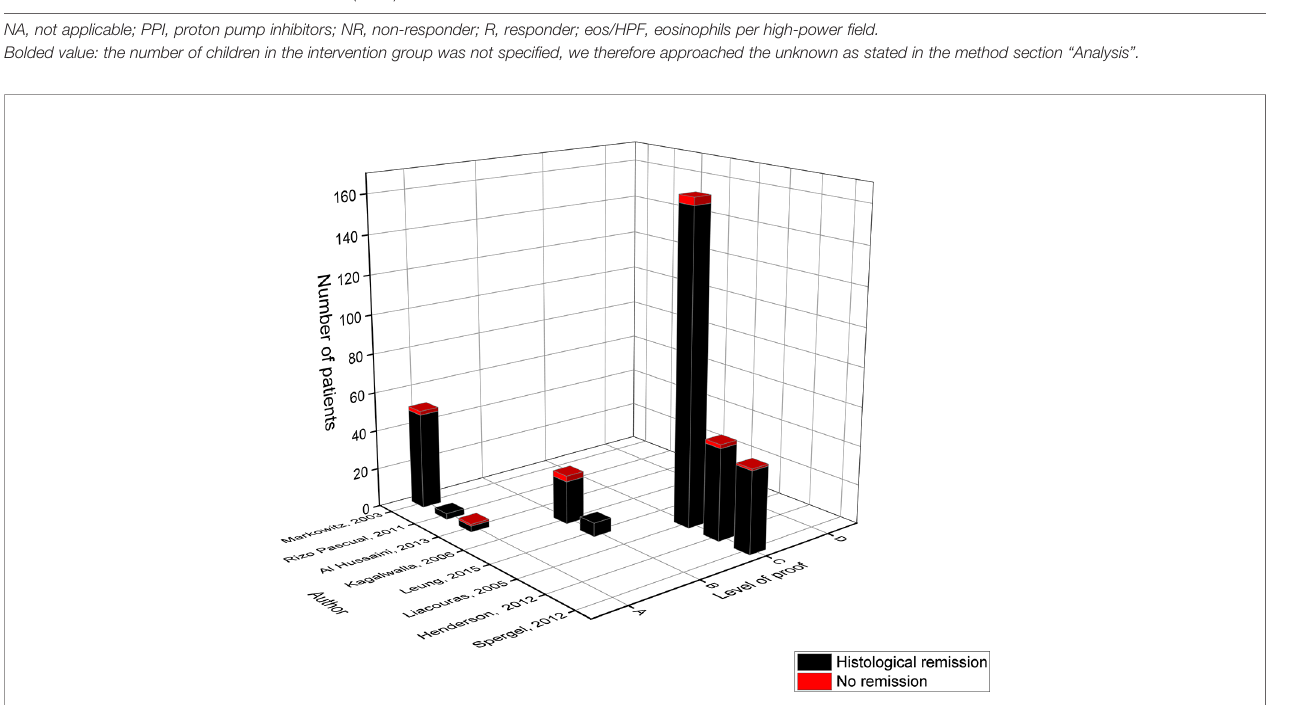
FIGURE 2 | Level of proof of studies on the elemental diet.